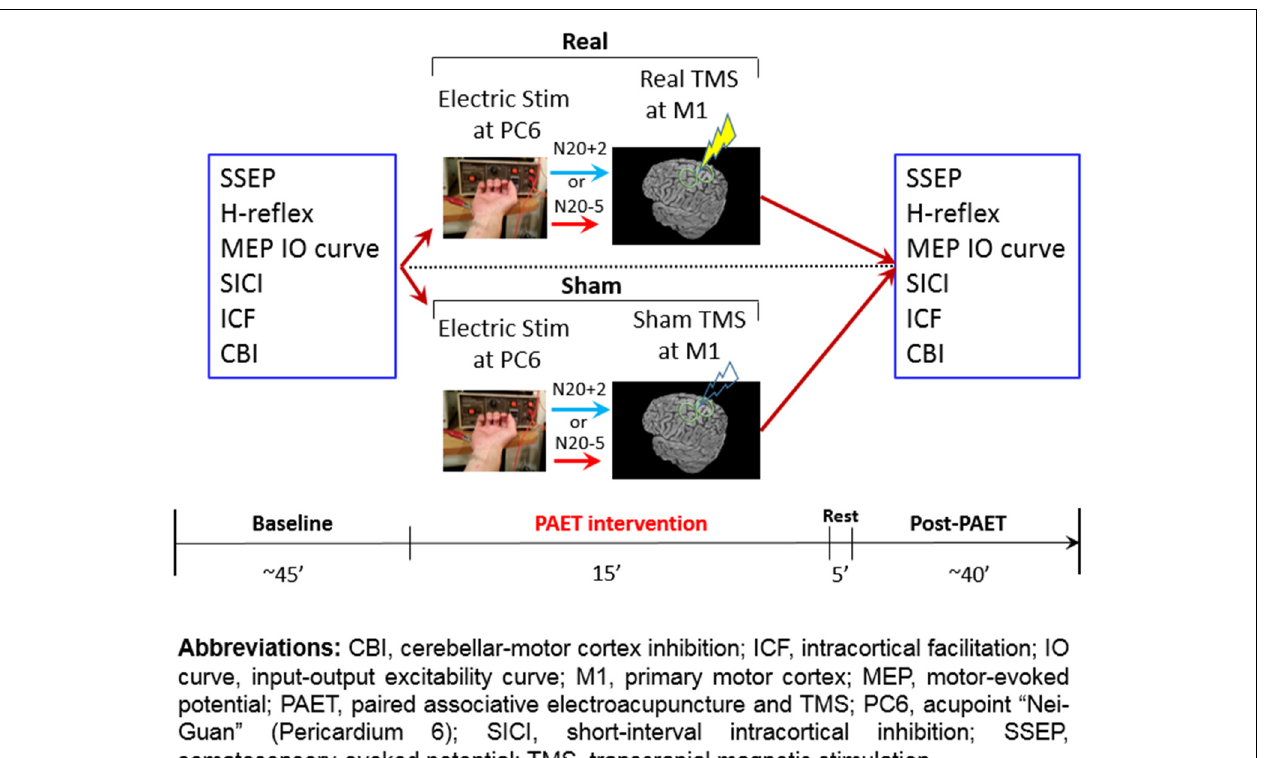
FIGURE 2 | Experimental design and the time line of the paired associative electroacupuncture and transcranial magnetic stimulation (TMS; PAET) study.